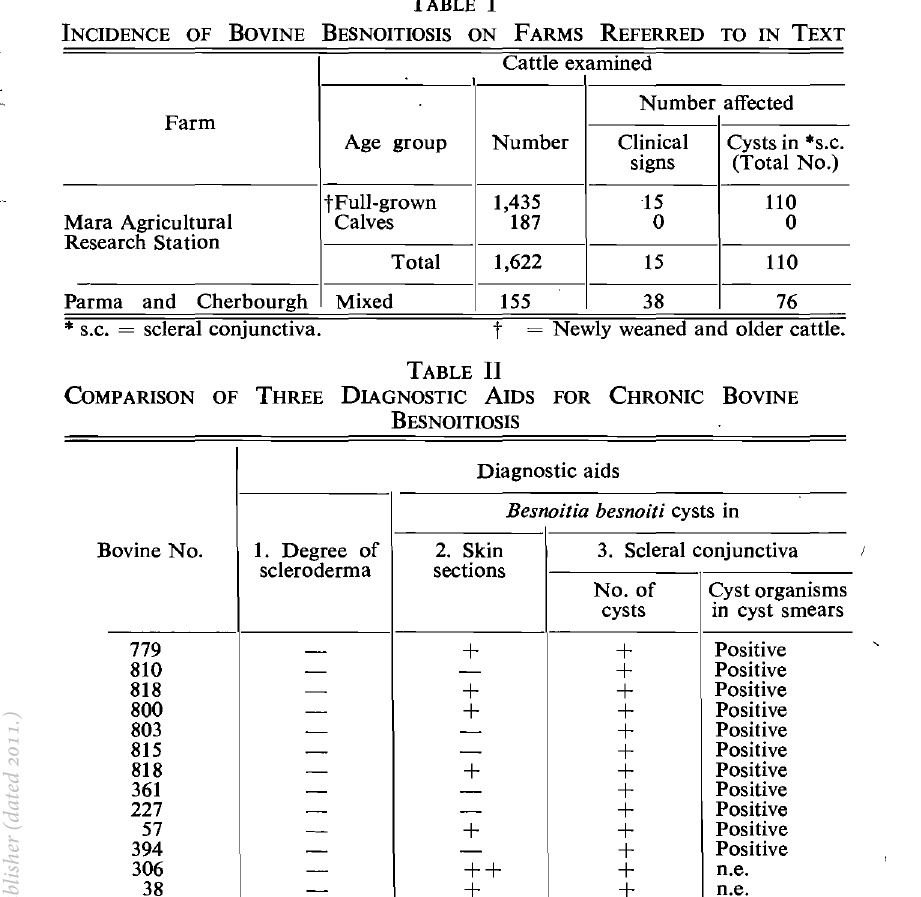
INCIDENCE OF BOVINE BESNOITIOSIS ON FARMS REFERRED TO IN TEXT